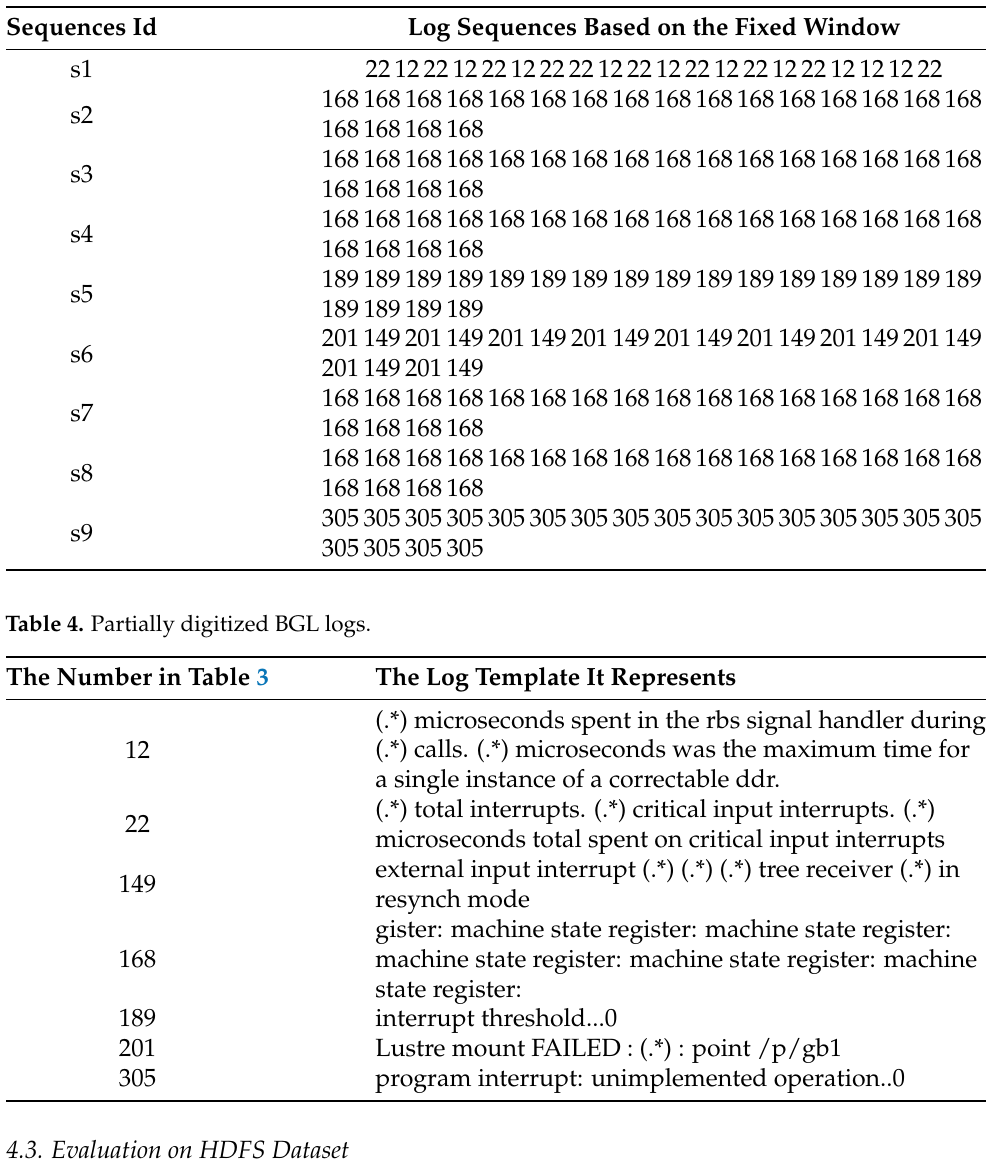
Table 3. Partially digitized BGL logs.